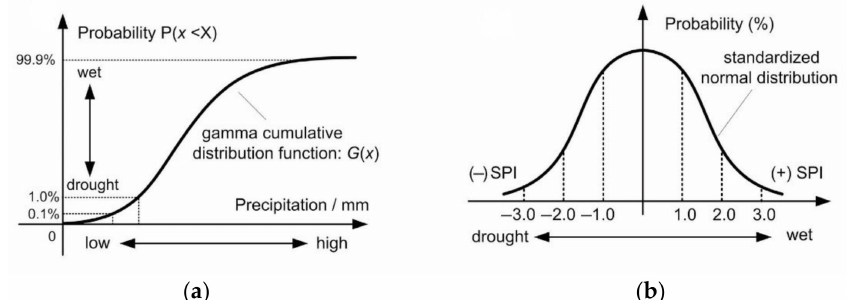
Figure 2. The normalized distribution applied by the SPI: ( a ) fitted gamma distribution for the cumulated monthly precipitation in Equations (5) and (6); ( b ) standardized normal distribution for SPI in Equation (8). Wetness is expressed by positive SPI values while dryness by negative